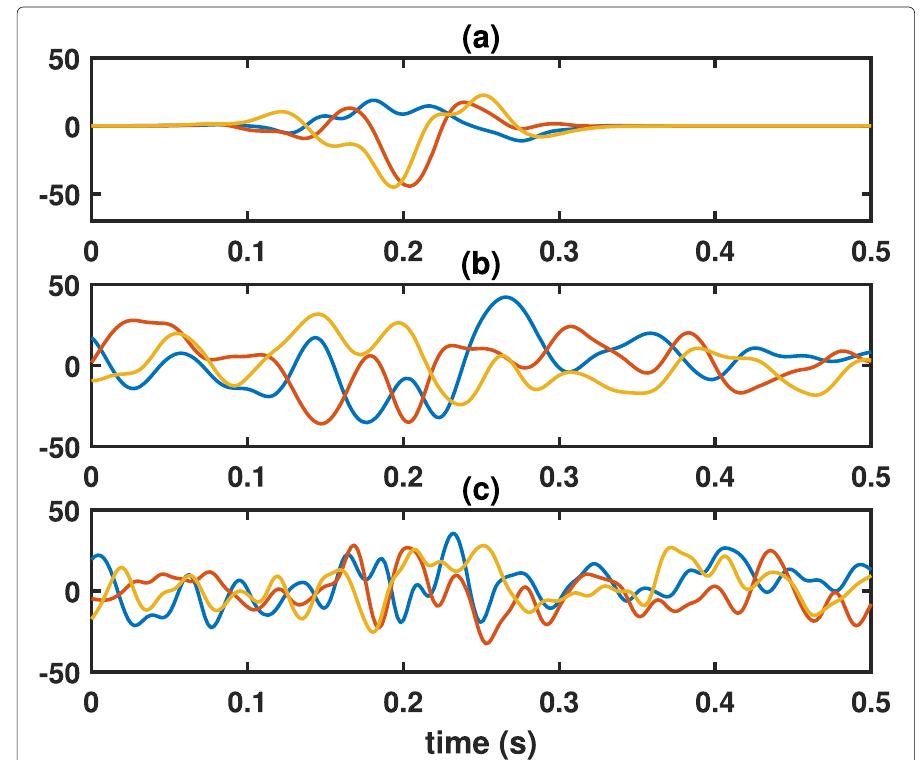
Fig. 1 Simulated realizations. Example of simulated realizations with model covariance defined by (8) and parameters ( L , a q , b q , c q , c r ) equal to a (0, 500, 0.20, 800, 15,000), b (120, 500, 0.20, 800, 15,000), and c (120, 500, 0.20, 800,